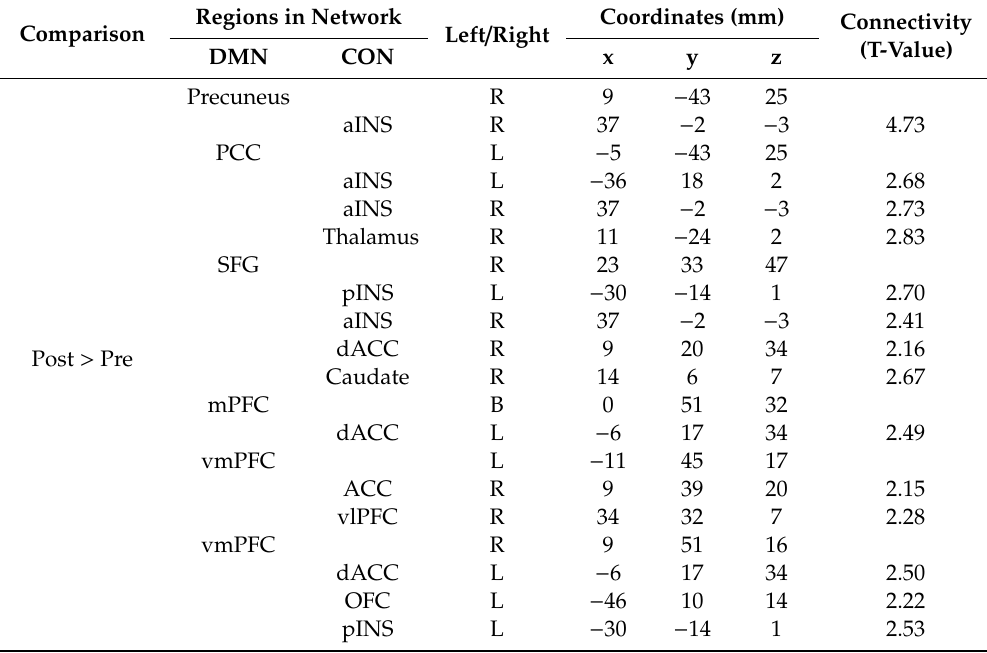
Figure 2. The functional connections between ROIs in CON and DMN, which showed high correlations with improved cognitive functions (executive and memory, motivation, decision- making, attention), as revealed by neurobehavioral tests.